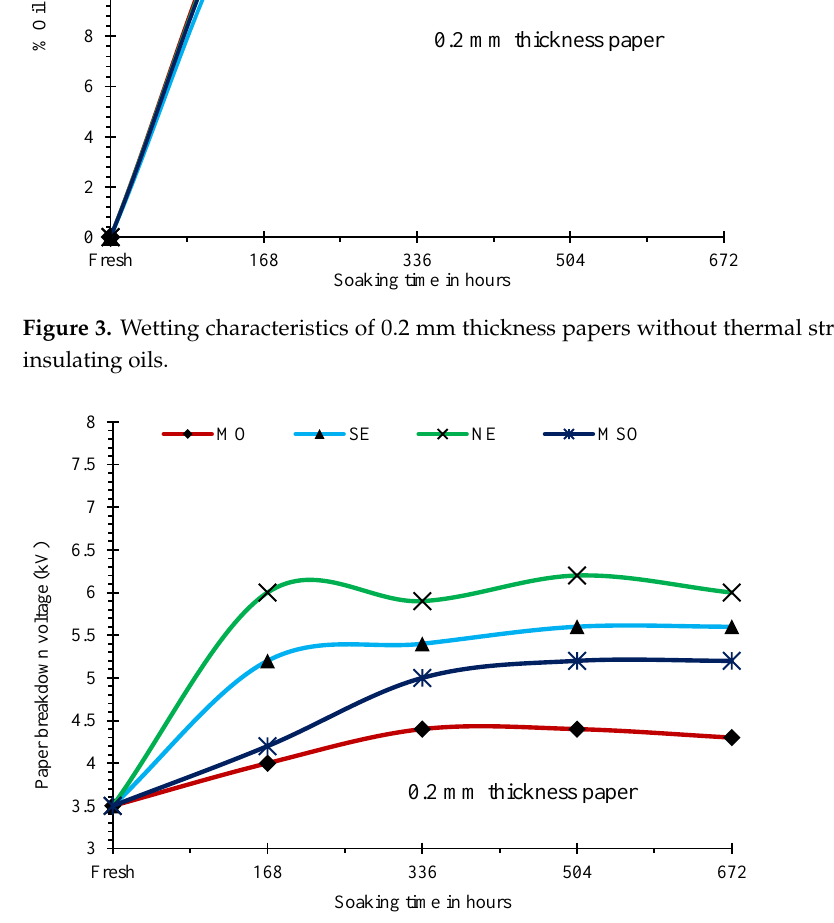
Figure 4. Change in paper BDV with the diffusion of various insulating oils for 0.2 mm thickness papers without thermal stresses.